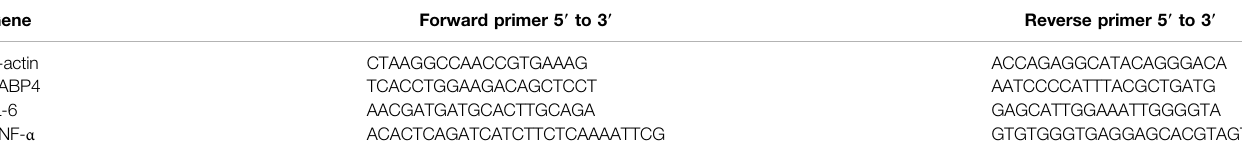
TABLE 1 | The sequence-speci fi c primers for RT-PCR.